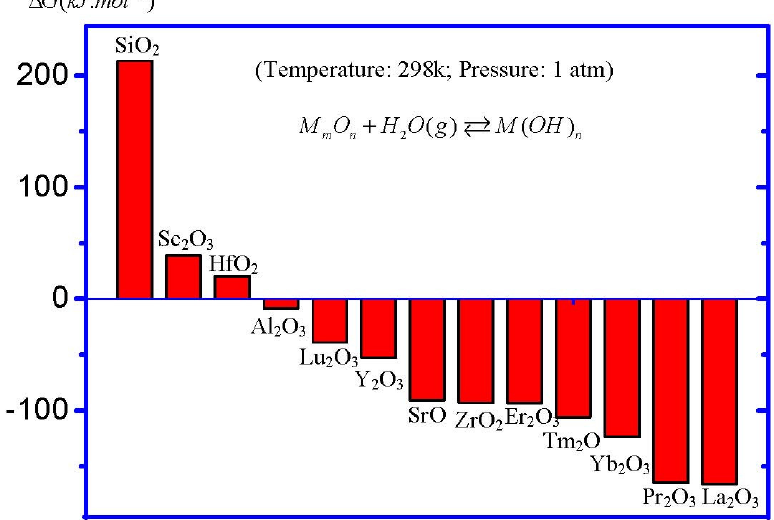
Figure 7. G ∆ of the moisture absorption reactions in high- k oxides under standard conditions. All entropy and enthalpy data of oxides, H from the database of HSC chemistry software, except for Hf(OH) from Reference [18].